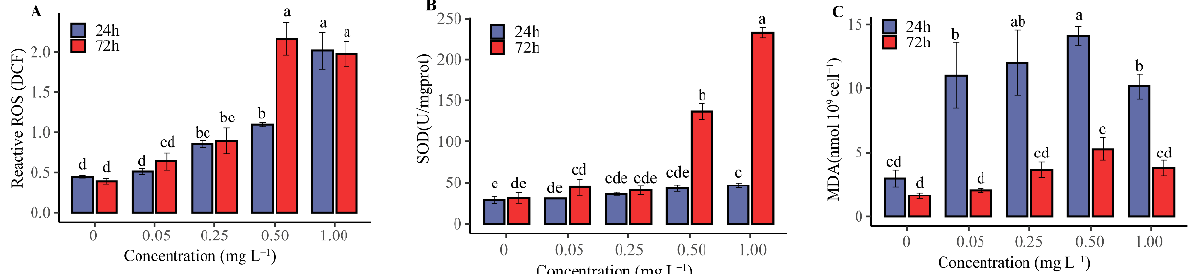
Figure 3. Algal cells were treated with cadmium at different concentrations for 24 h and 72 h. ( A ) ROS content, ( B ) SOD activity, and ( C ) MDA content. According to the one-way ANOVA test, different alphabet letters indicated a significant difference in the treatment group at p < 0.05.